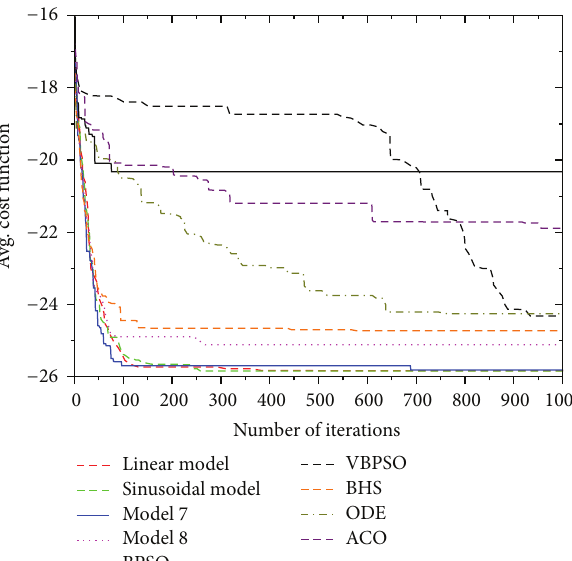
Figure 5: Convergence rate graph for the 300-element asymmetric thinned array.